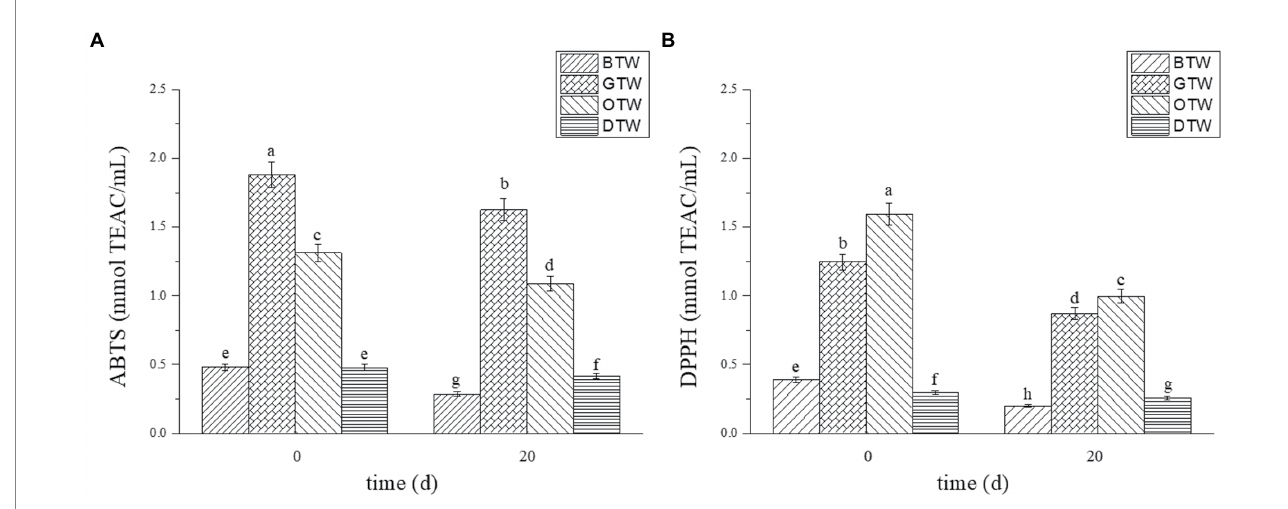
FIGURE 4 The antioxidant evaluation assays of ABTS (A) and DPPH (B) scavenging abilities on tea wines. Different letters (a, b, c, d, e, f, g, h) in the same column indicate significant differences between the mean values ( p < 0.05).